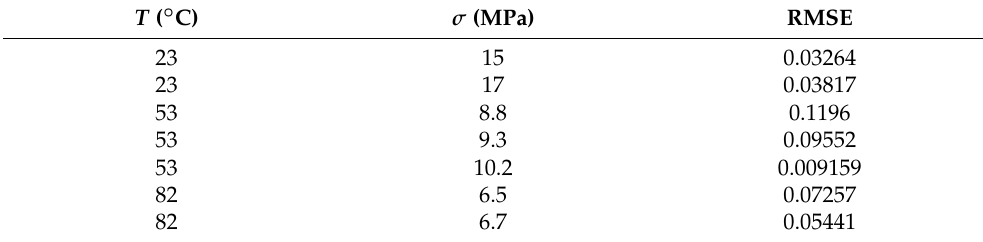
Table 4. RMSEs of the model prediction for the creep strain data reported in Ref.